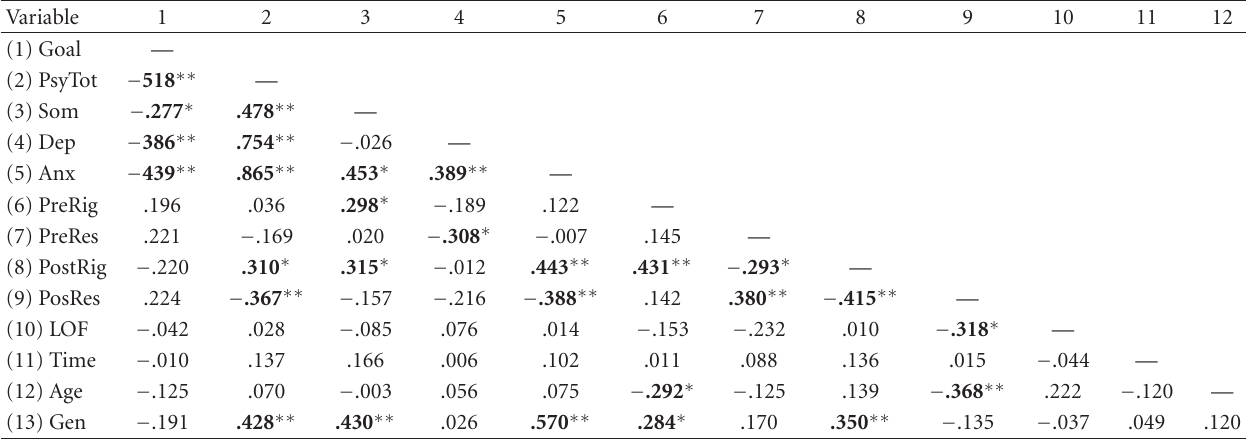
Table 2: Bivariate correlations of independent variables, control variables, and dependent